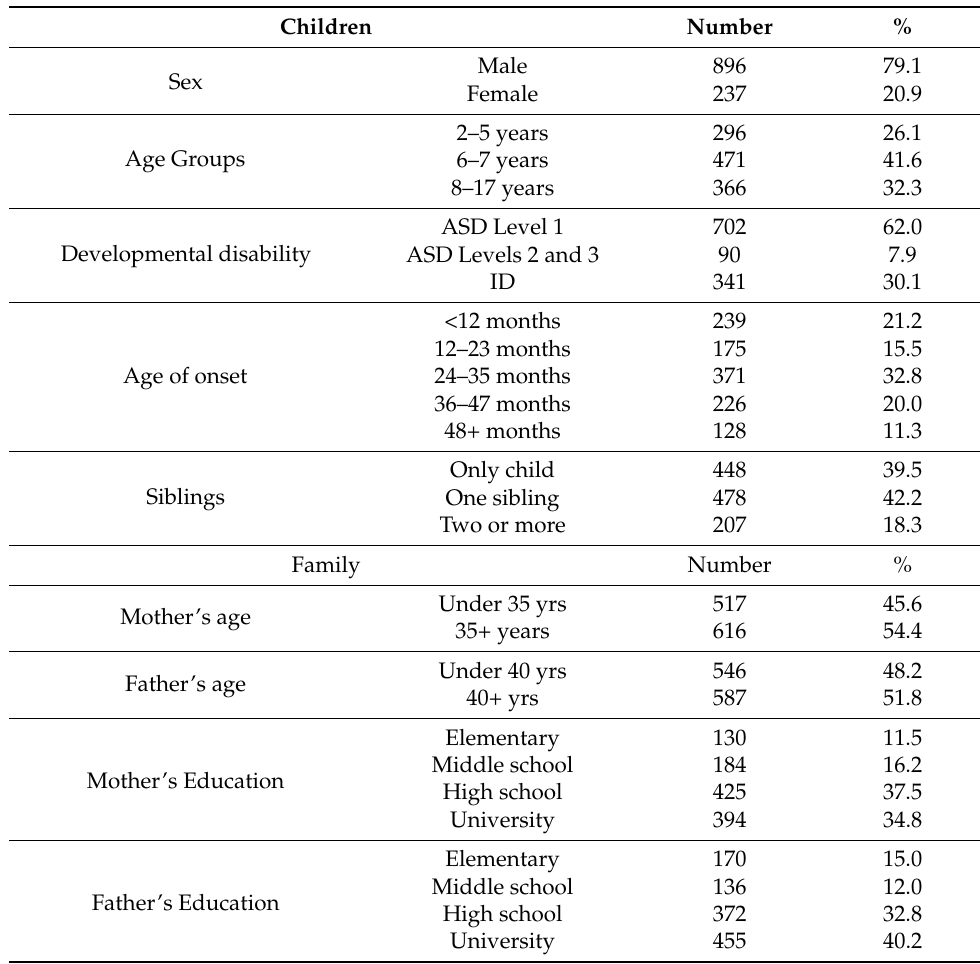
Table 1. The demographic characteristics of the sample ( n =